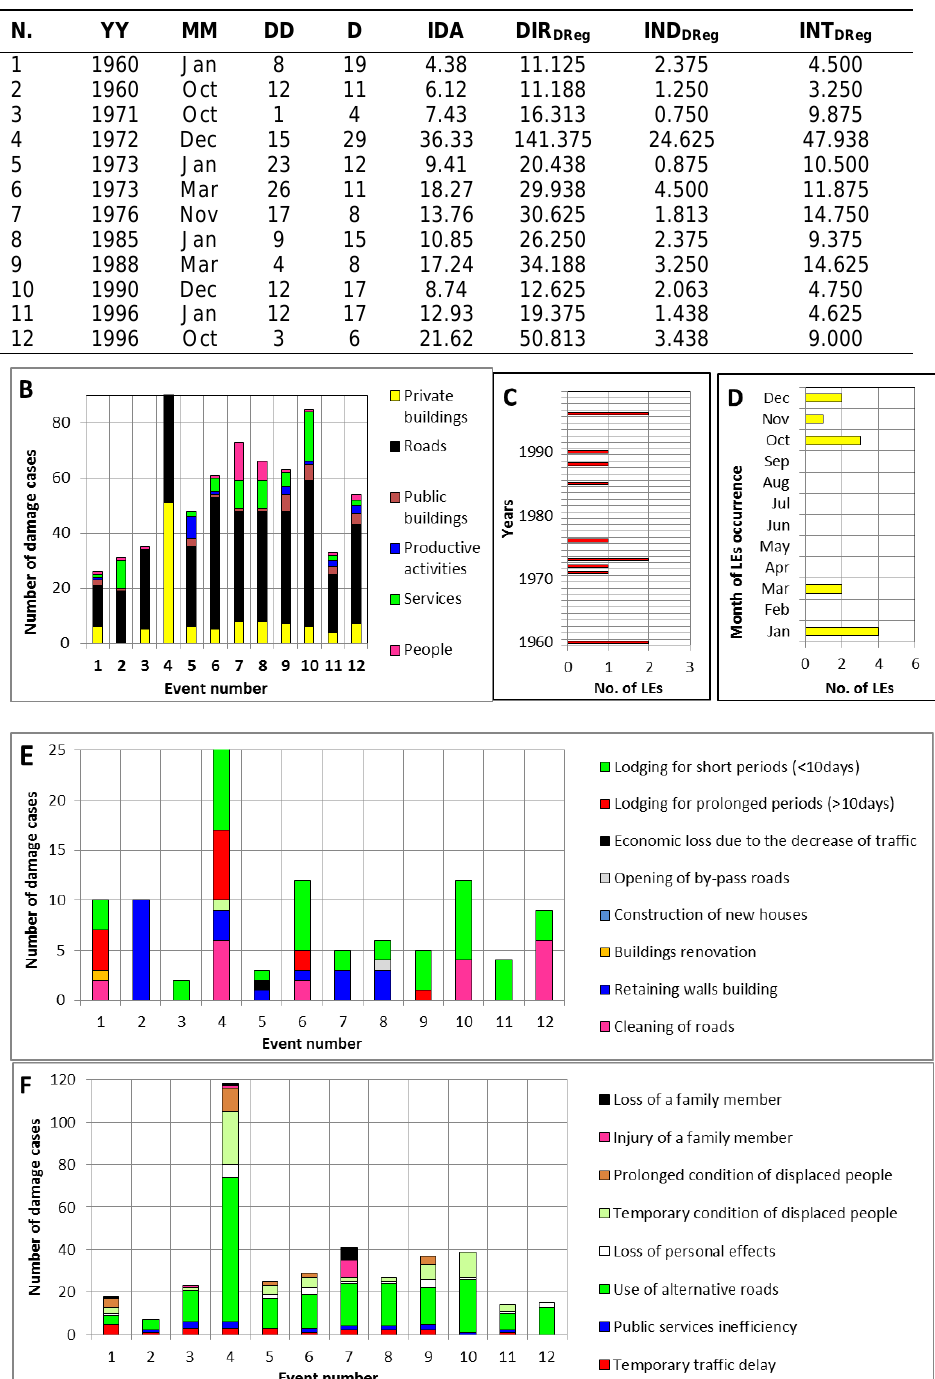
Figure 1. A: The analysed LEs. For each event, the beginning of damage occurrence (year: YY; month: MM; and day: DD), the Index of Damaged Area (IDA) and direct (DIR Dreg ), indirect (IND DReg ) and intangible damage (INT DReg ) assessment at regional scale are reported. In (C) and (D) : annual and monthly frequency of LEs. B, E and F present the number of data concurring to the determination of direct, indirect and intangible damage, respectively.